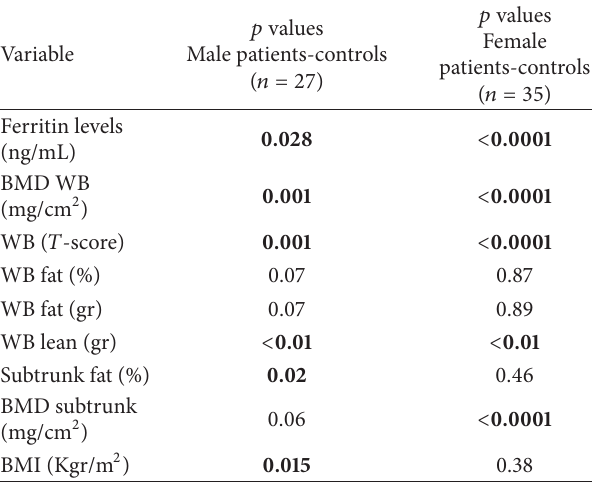
Table 2: 𝑝 values of body composition variables between male and female patients and controls.